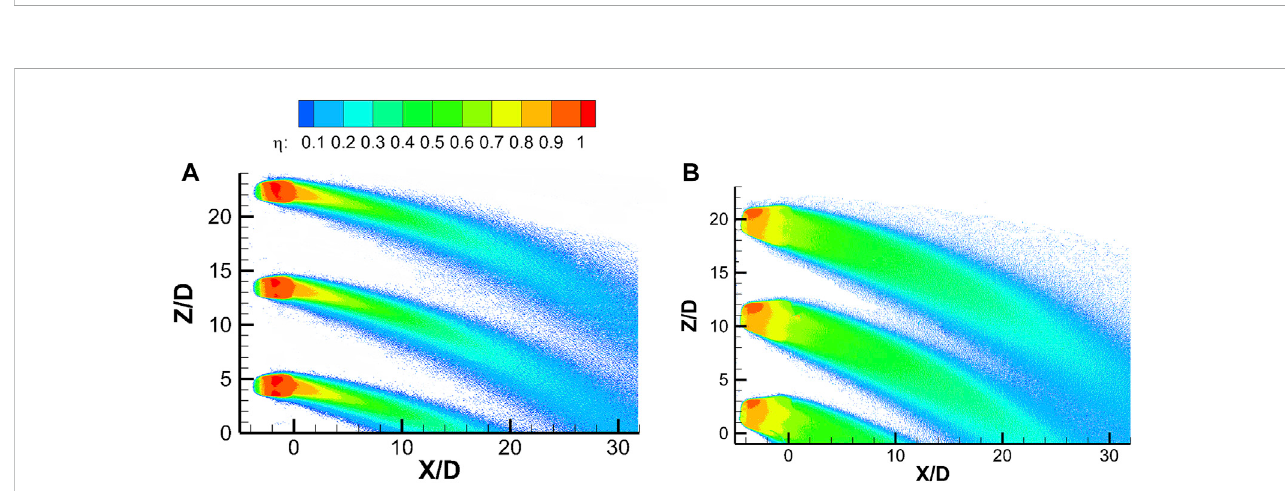
FIGURE 13 Adiabatic fi lm cooling effectiveness contour under blowing ratio of 2.0: (A) baseline hole and (B) optimized hole.